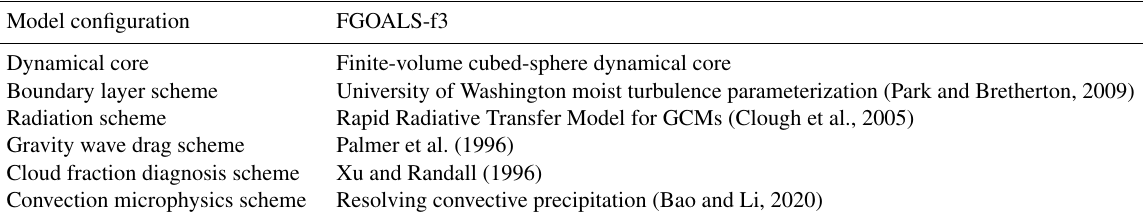
Table 1. Dynamical core and physics parameterization schemes used in